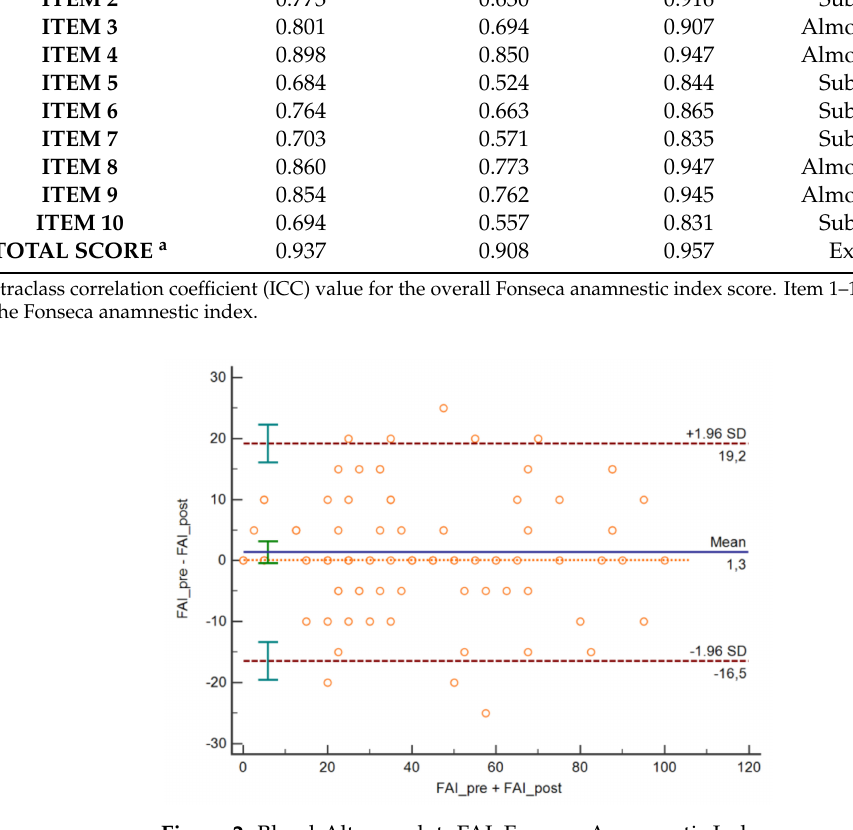
Figure 2. Bland-Altman plot. FAI: Fonseca Anamnestic